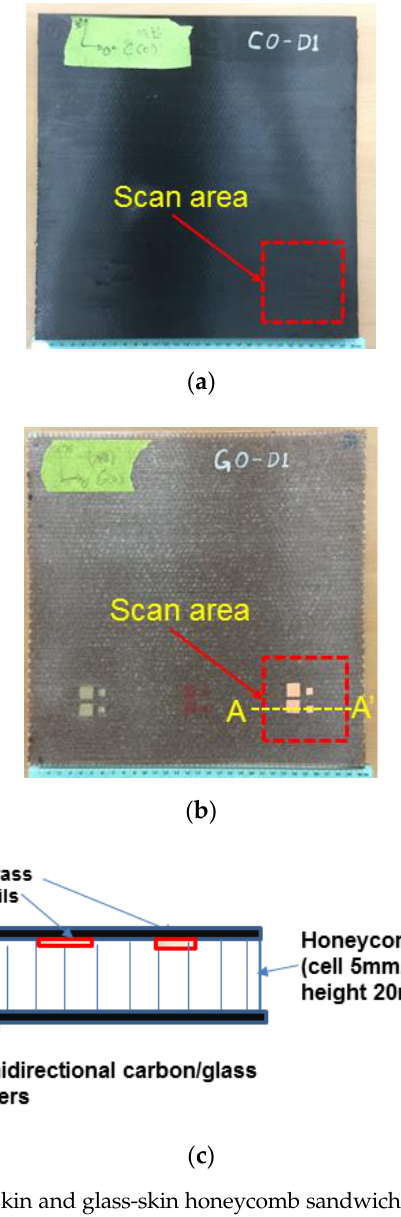
Figure 4. Samples of carbon-skin and glass-skin honeycomb sandwich composite panels with foreign materials. ( a ) Carbon-skin honeycomb composite panel with foreign materials. ( b ) Glass-skin honeycomb composite panel with foreign materials. ( c ) Stacking sequence of honeycomb composite panel at the A-A’ line.